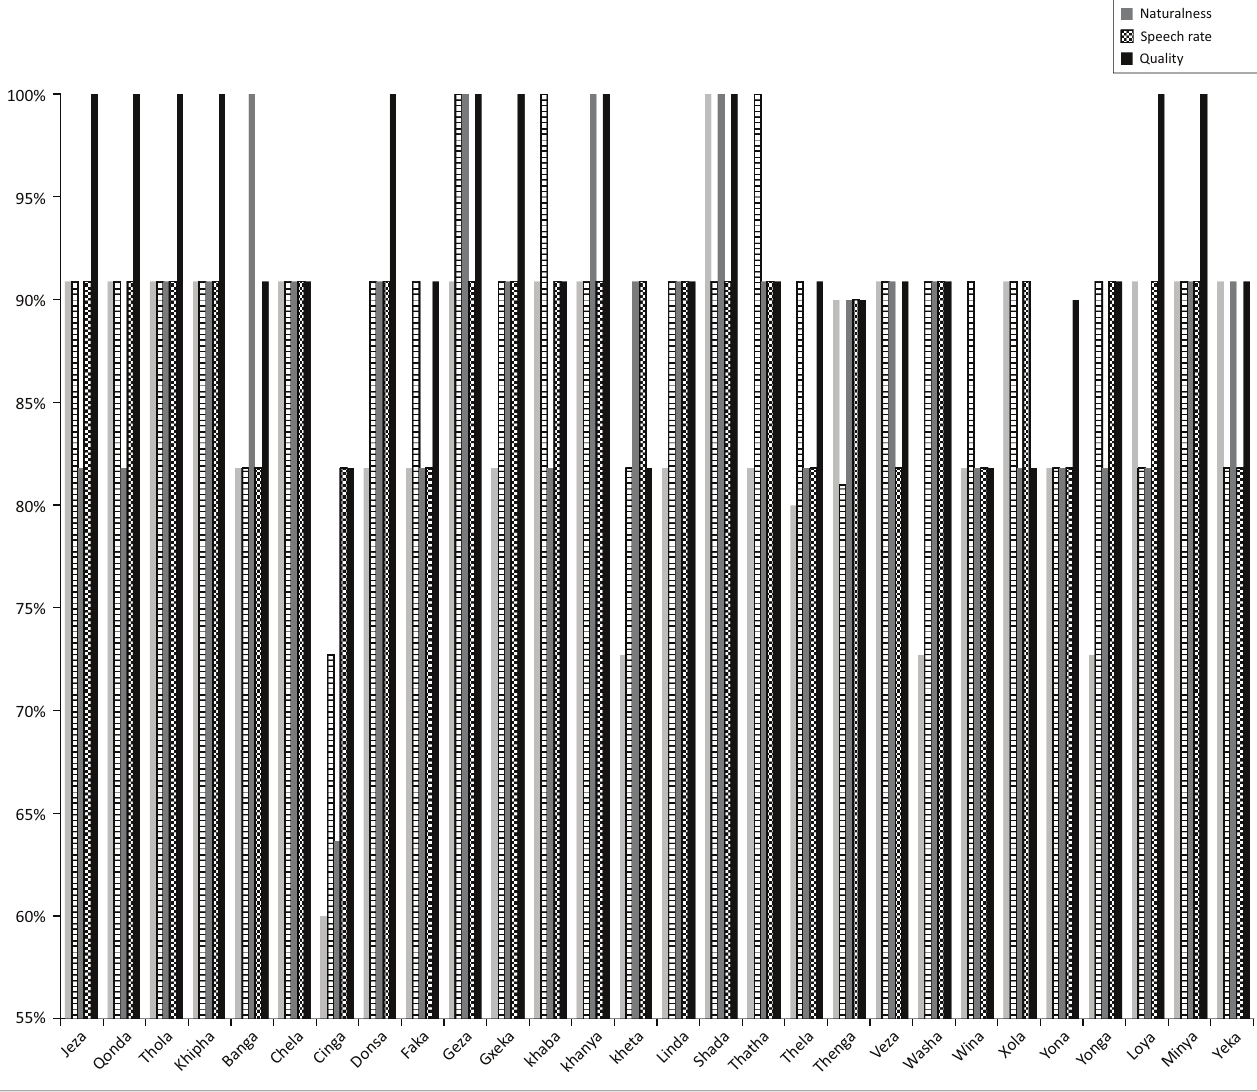
FIGURE 2: Percentage of raters strongly agreeing in each rating category for each of the 28 recorded isiZulu